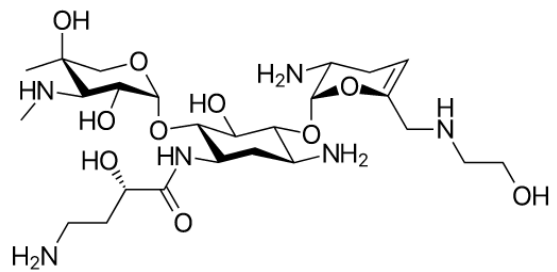
Figure 7. Formula of plazomicin.